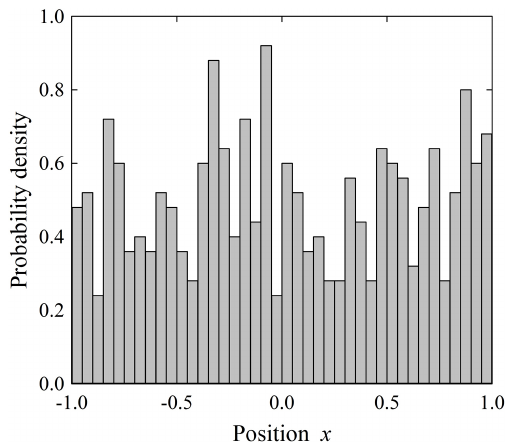
Figure C3. Histogram of particle positions x at time t → ∞ for one system showing that with a modest number of particles repre- senting a rarefied condition this histogram is irregular and discon- tinuous; in this example N = 500. Figure reproduced from Furbish et al.